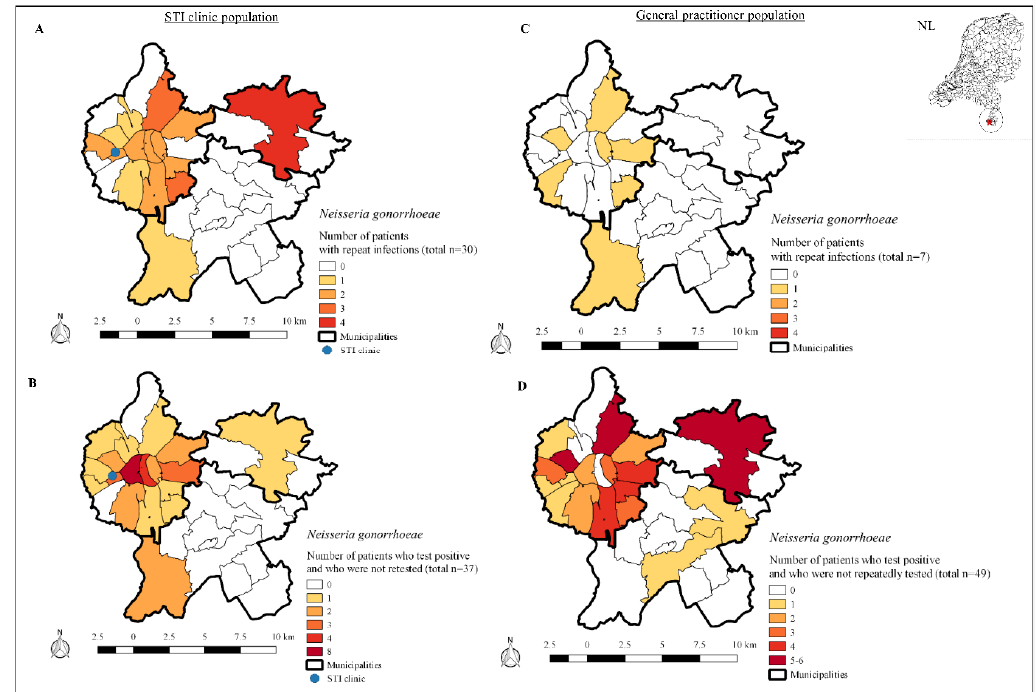
Figure 2. Geographical maps of patients infected with Neisseria gonorrhoeae.